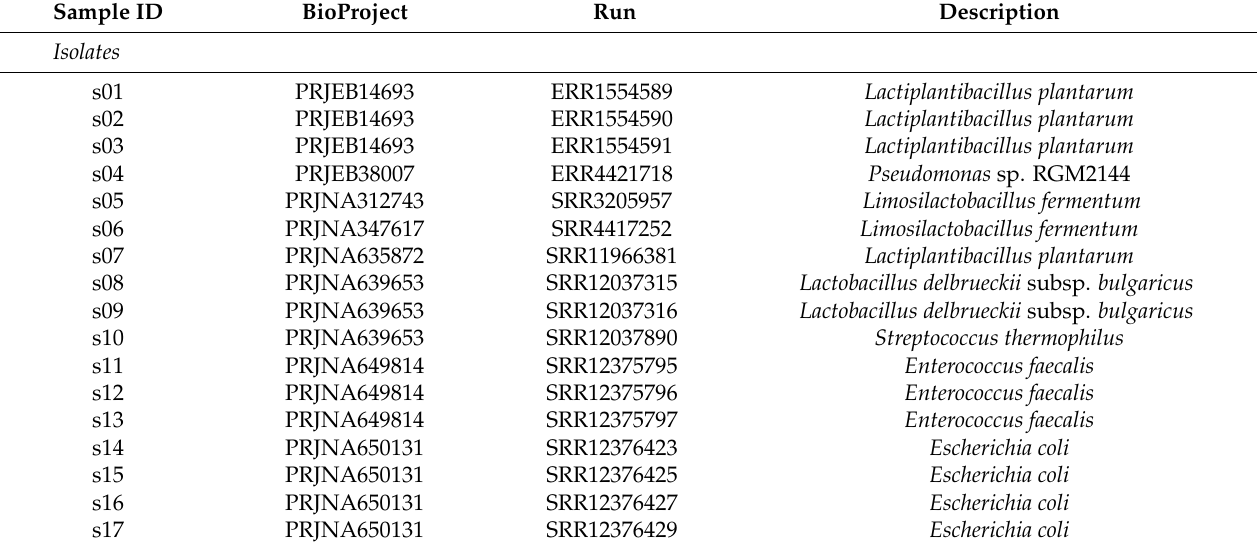
Table 1. The list of analysed samples obtained from NCBI SRA. In the unified names of the samples the first character corresponds to the type of the sample (s and m, isolate and metagenome, respectively), the second tag is a sequence number. Except the signed (*) all samples were paired end sequenced. The last column shows the available information about the